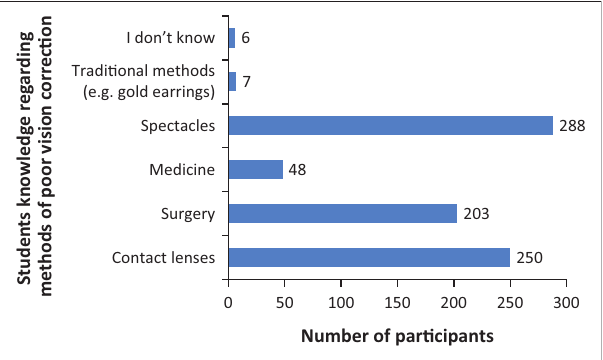
FIGURE 2: Participants perception regarding methods of vision